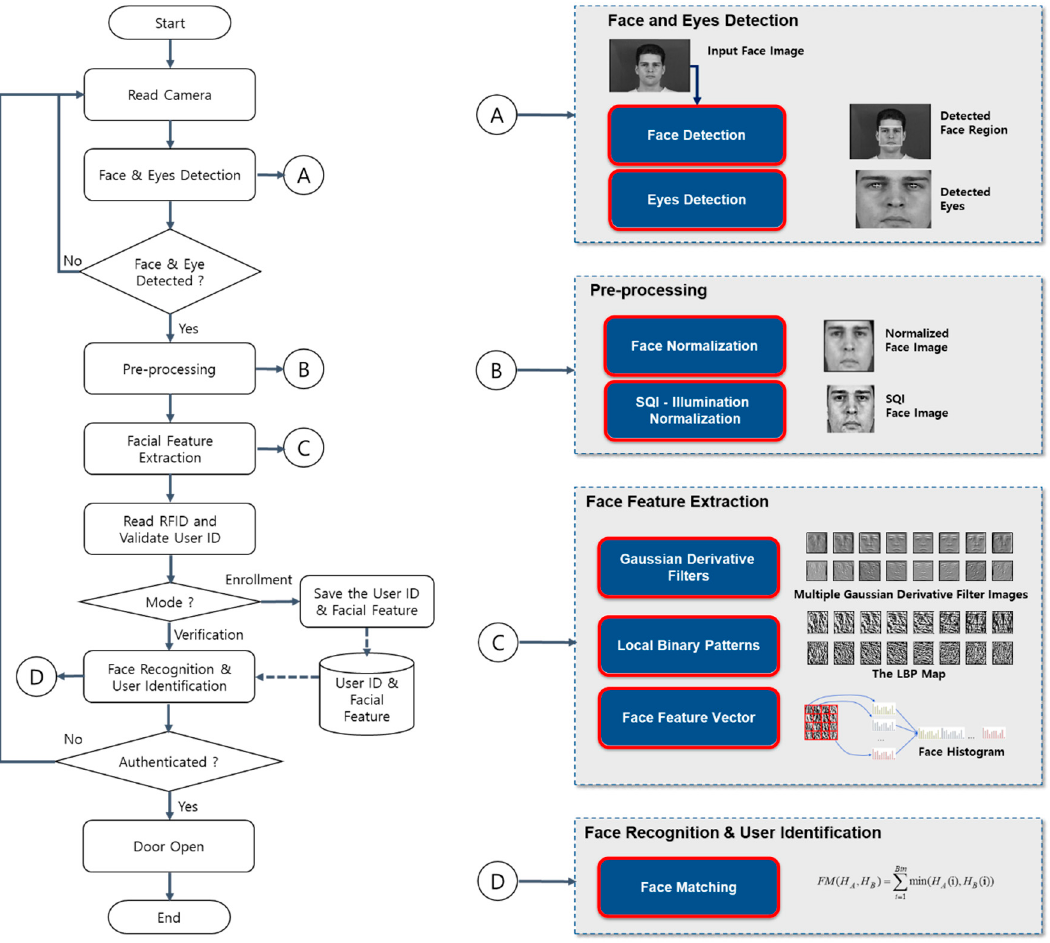
Figure 1. Overall process of the face recognition for a stand-alone access control system. RFID: ???, SQI: self-quotient image.